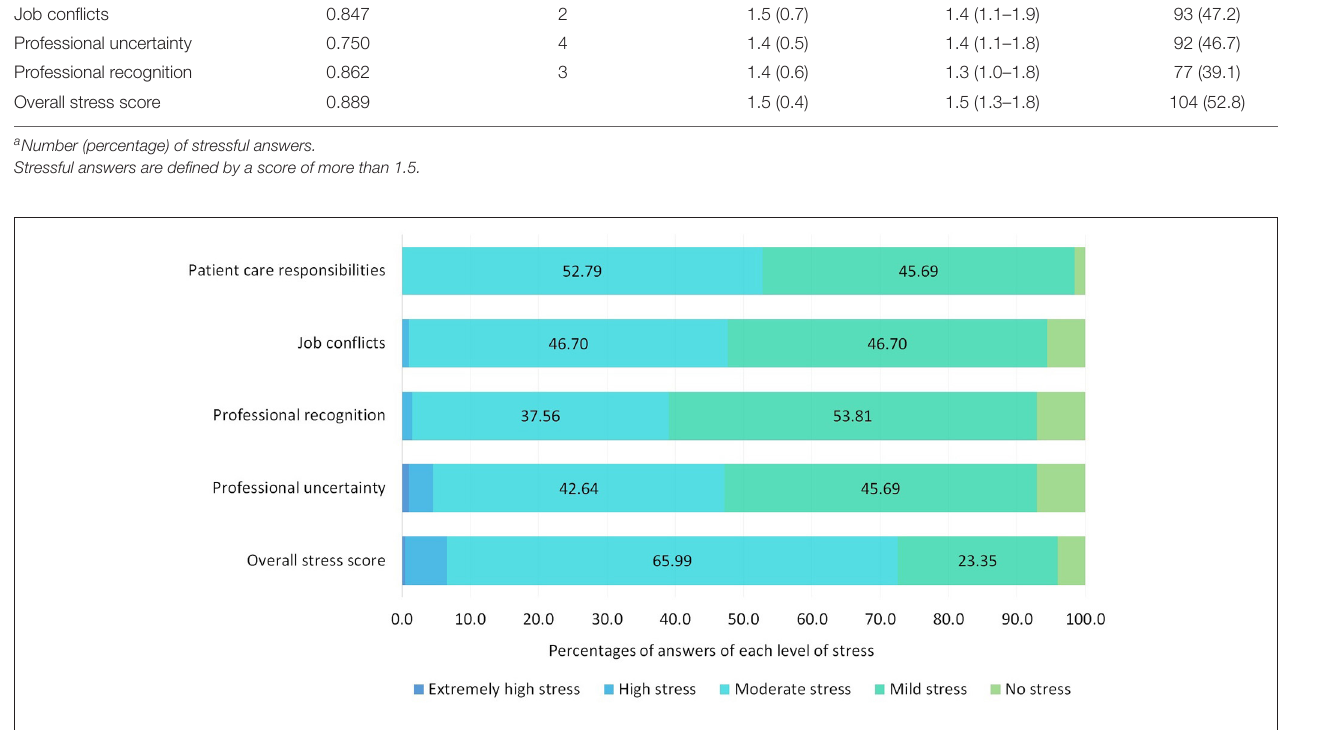
FIGURE 2 | Number of answers of each level of stress for each subset and overall domain.